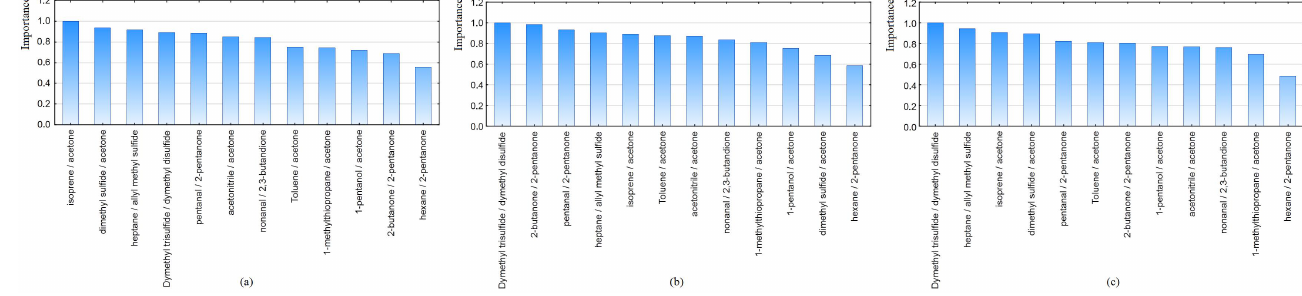
Figure 2. Importance bar plots of variables using GBDT, created on the datasets ( a ) 1, ( b ) 2, ( c )